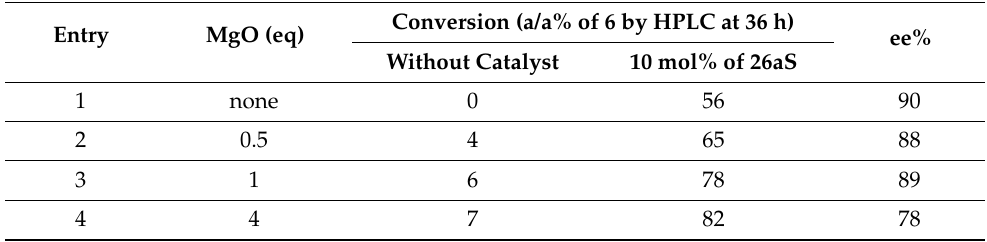
Table 5. Examining the effect of MgO stoichiometry in the Pinder reaction in the presence and absence of catalyst